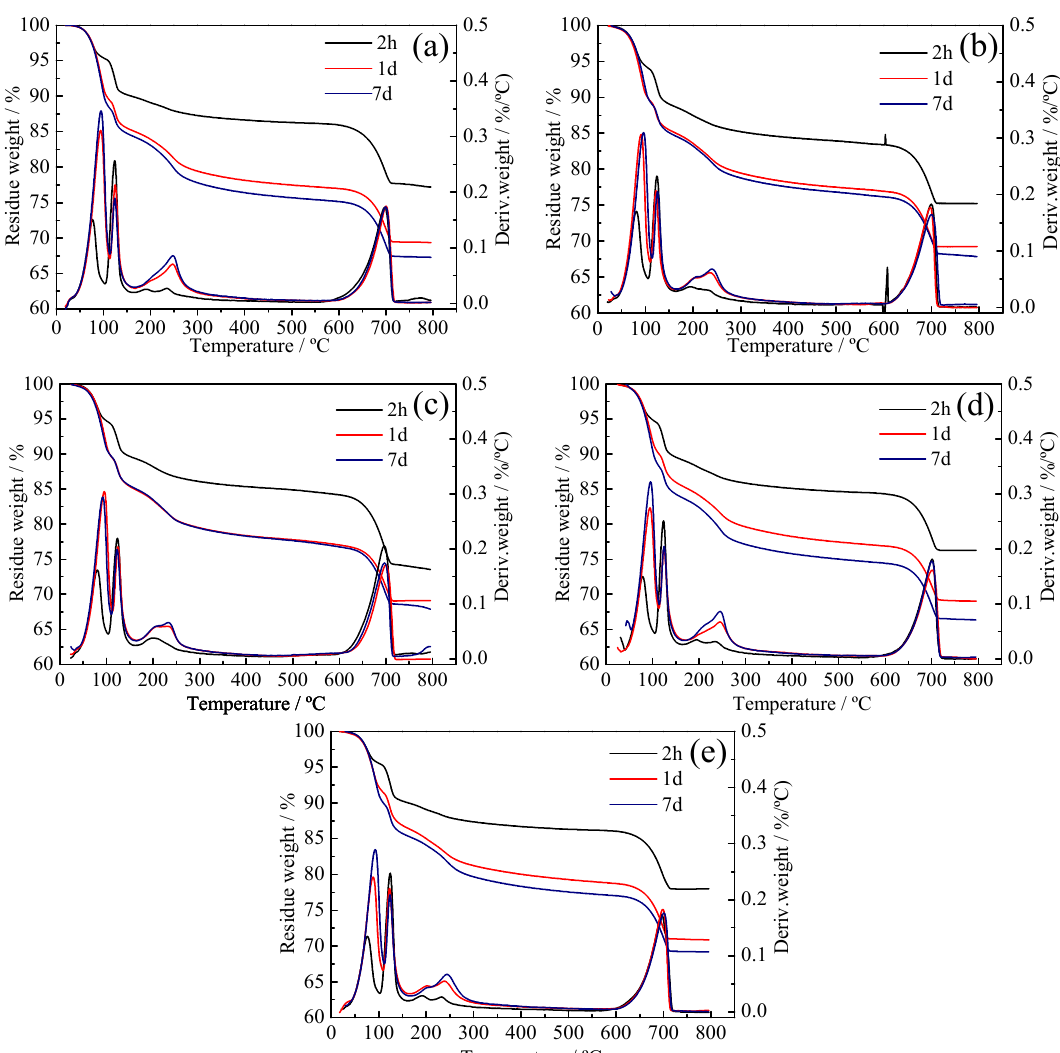
Figure 5. TG curves of CSA pastes with superplasticizers for 2 h, 7 d, 28 d ( a ) BNS-0.8%, ( b ) BNS-2.0%, ( c ) PC-0.08%, ( d ) PC-0.20%.